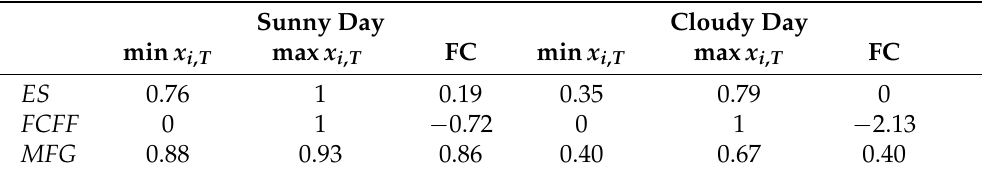
Table 2. Comparison of fairness coefficient and departing SOCs (min x i ,0 = 0 and max x i ,0 = 0.45) for a fixed population of 400